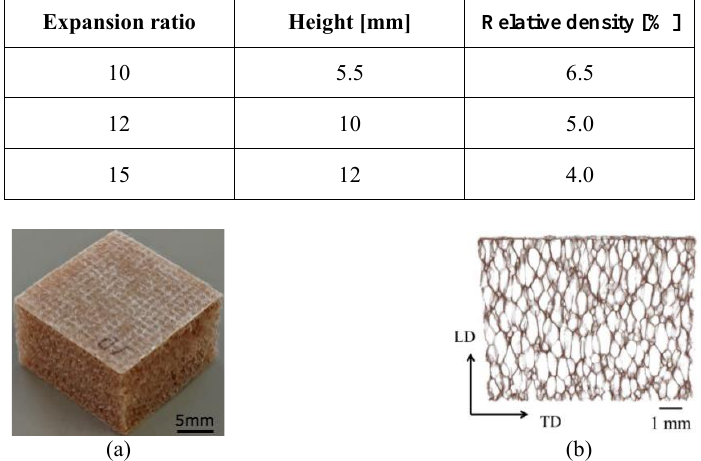
Fig. 1. Test piece (expansion ratio of 12); (a) Macroscopic view, (b) cross-section